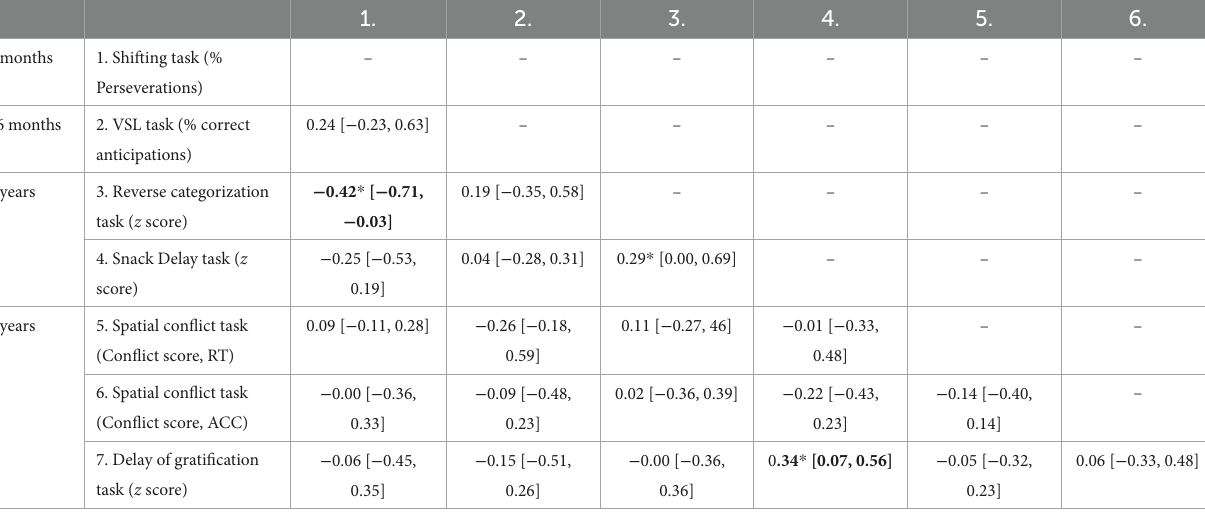
TABLE 2 Correlations among different measures of executive attention in infancy and